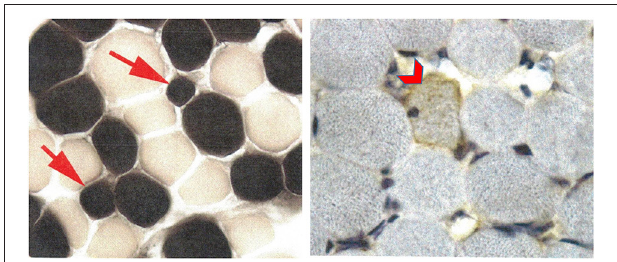
FIGURE 2 | Patient 2 muscle biopsy. ATPase reaction at pH 4.3 shows a few, but not all, type 1 myofibers to be atrophic (arrows) without angulated contours. Neural cell adhesion molecule (NCAM) is weakly positive in a rare myofiber (chevron) without evidence of myopathic or neurogenic